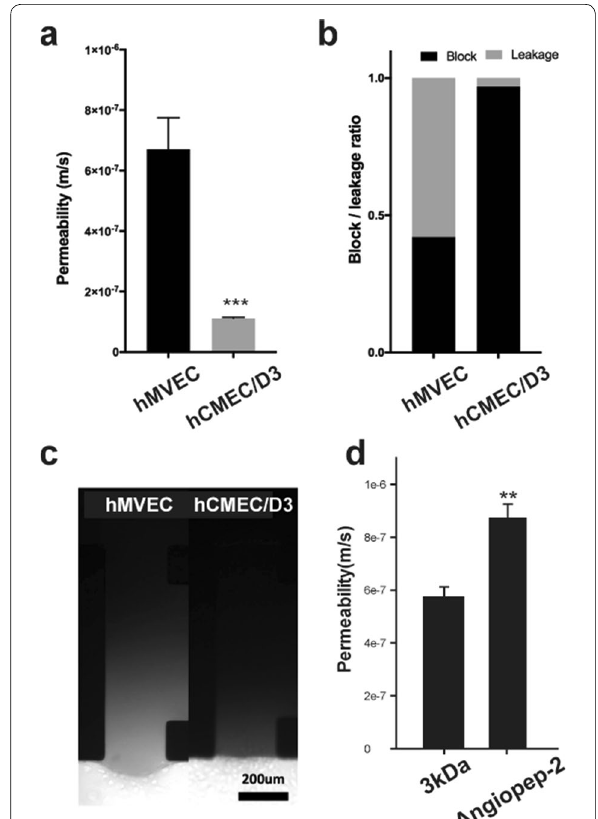
Fig. 3 Quantification graphs of permeability and block/leakage ratio in the microfluidic device. a Permeability graph comparing two types of endothelial cells, hCMEC/D3 and hMVEC, they were treated with 3 kda FITC‑dextran for 15 min. b Block/leakage ratio graph and c fluorescence images of hCMEC/D3 and hMVEC monolayer after treatment of dextran. d Permeability graph of angiopep‑2 with 3 kda dextran. Data represent mean S.E.M. ** p < 0.01, *** p < 0.001 by Student’s t